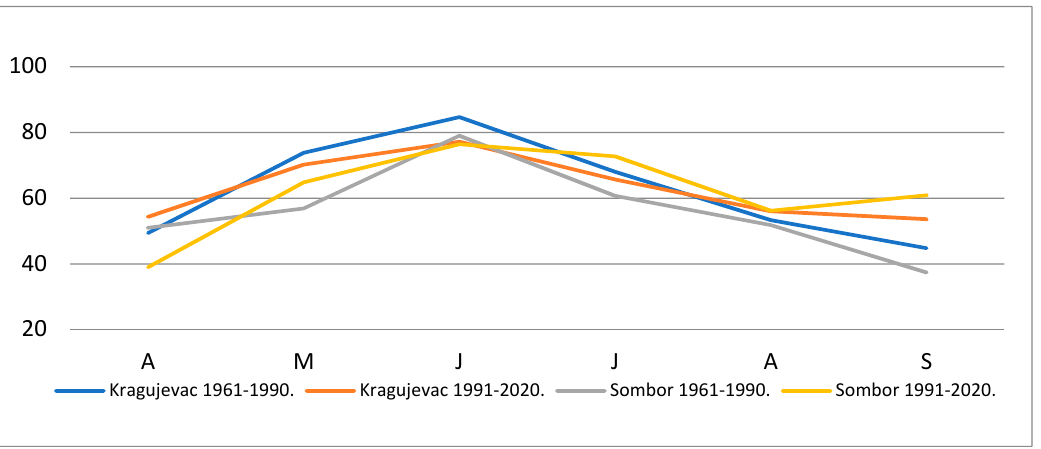
Figure 6. Amount of precipitation in average per month from growth stage to ripening of maize (April-September) in Kragujevac and Sombor for the periods 1961–1990 and 1991–2020. Source: RHMS-Meteorological yearbooks.